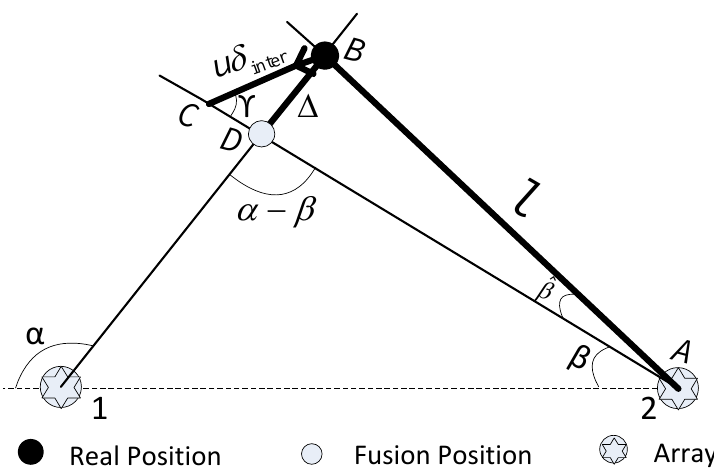
Figure 5. Method of obtaining the target’s